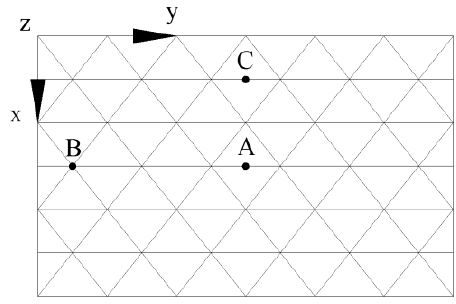
Figure 6. Part of the measurement points.